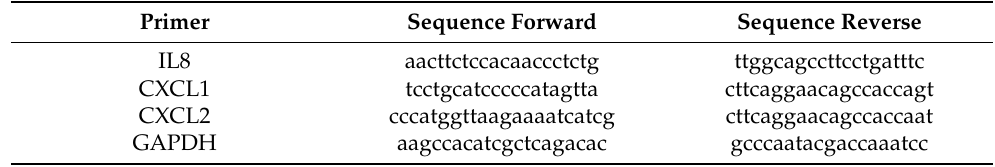
Table 4. Human primers